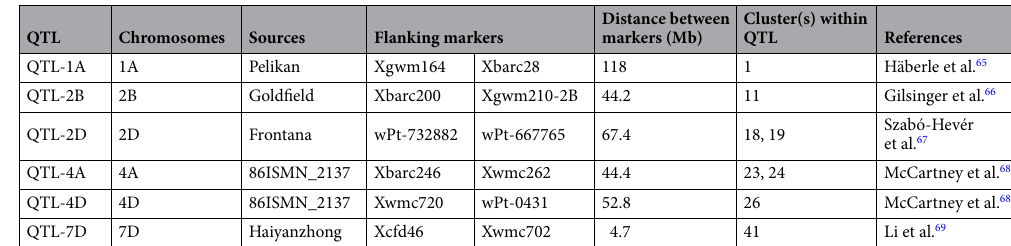
Table 2. FHB QTL that are smaller than 150 Mb and encompass